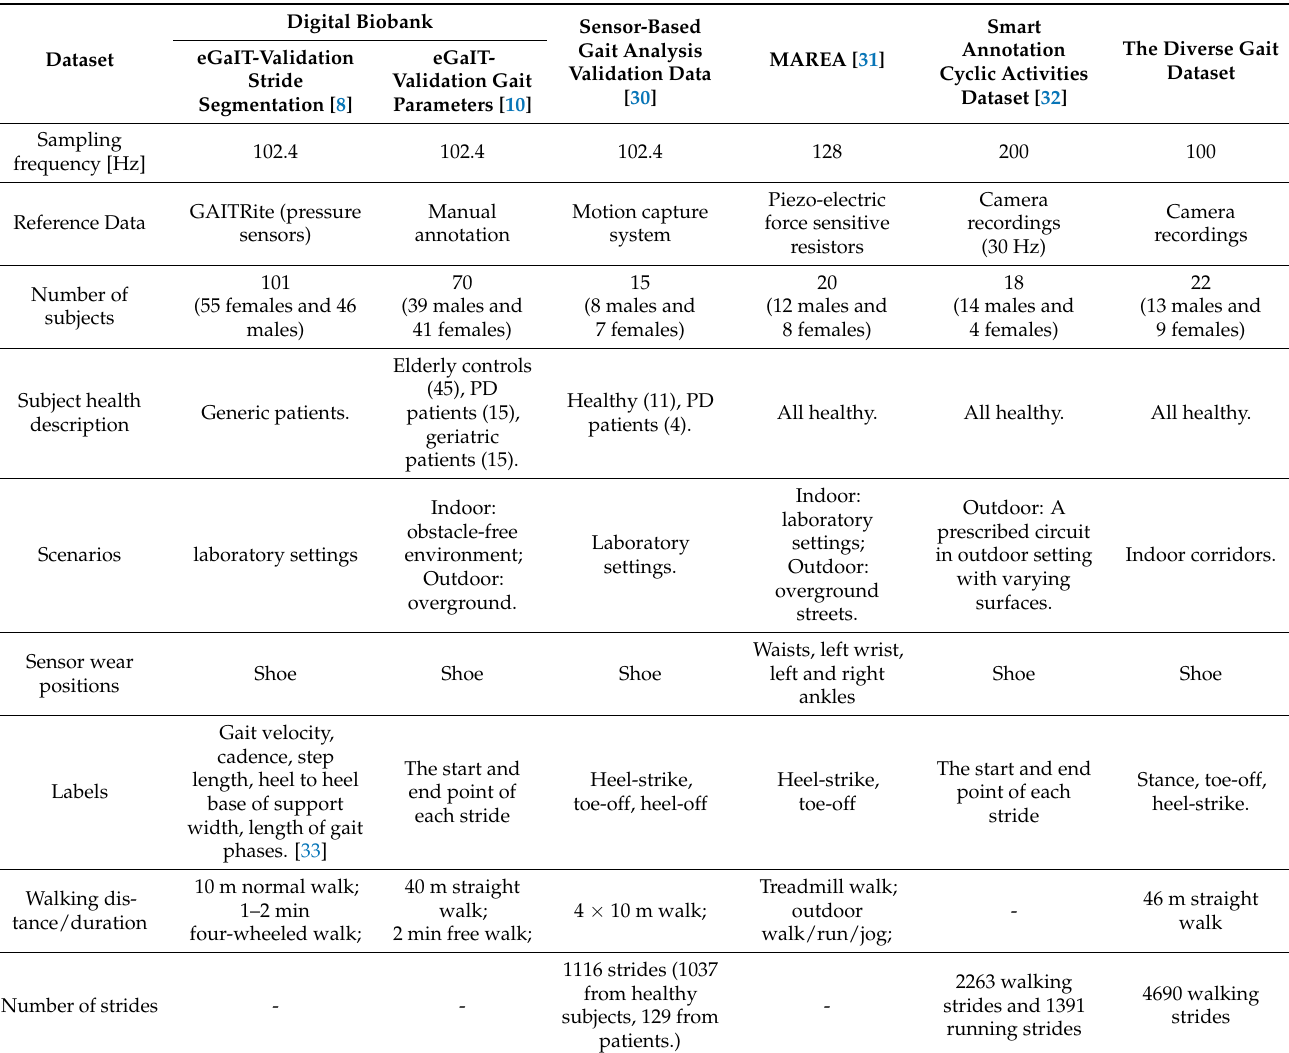
Table 1. Summary of published gait